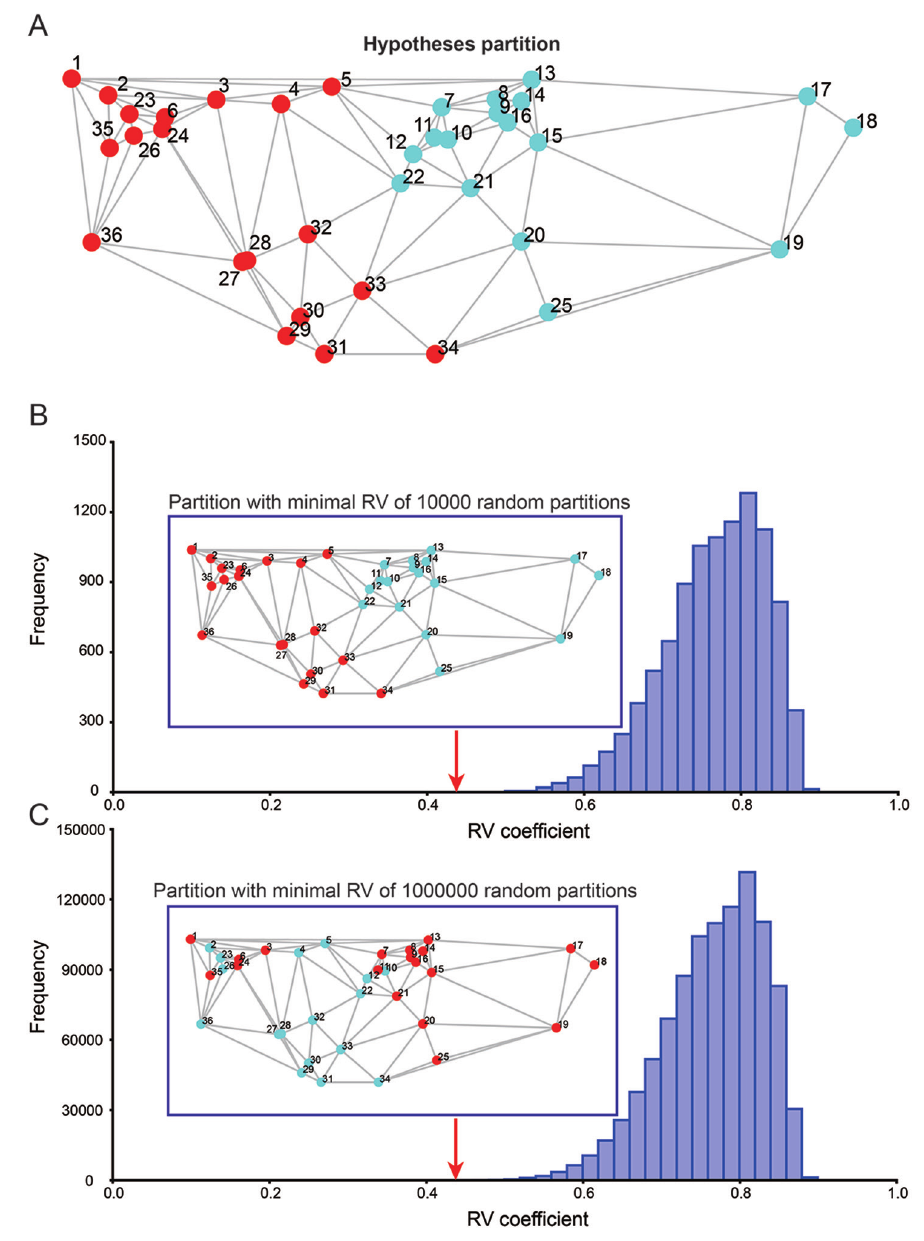
Figure 4. Modularity test results. A The hypothesized partition: proximal part landmarks 1-6, 23, 24, and 26–36 and distal part landmarks 7–22, 25; different colour presents different modules B The parti- tion with minimal covariance in all evaluated 10 4 partitions by RV coefficient C The partition with mini- mal covariance in all evaluated 10 6 partitions by RV